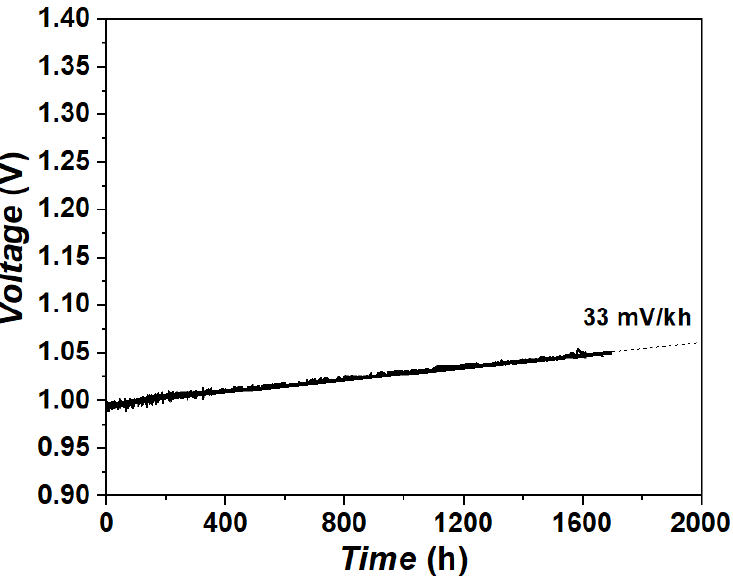
Figure 3. Long-term stability test, i.e., cell voltage vs. time curve for the 3Mo-3Au-Ni- GDC/8YSZ/GDC/LSCF single cell up to 1700h at 900 °C with 7 vol.% H 2 , 30 vol.% N 2 , and 63 vol.% H 2 O feed gas mixture under − 0.3 A · cm − 2 current load.